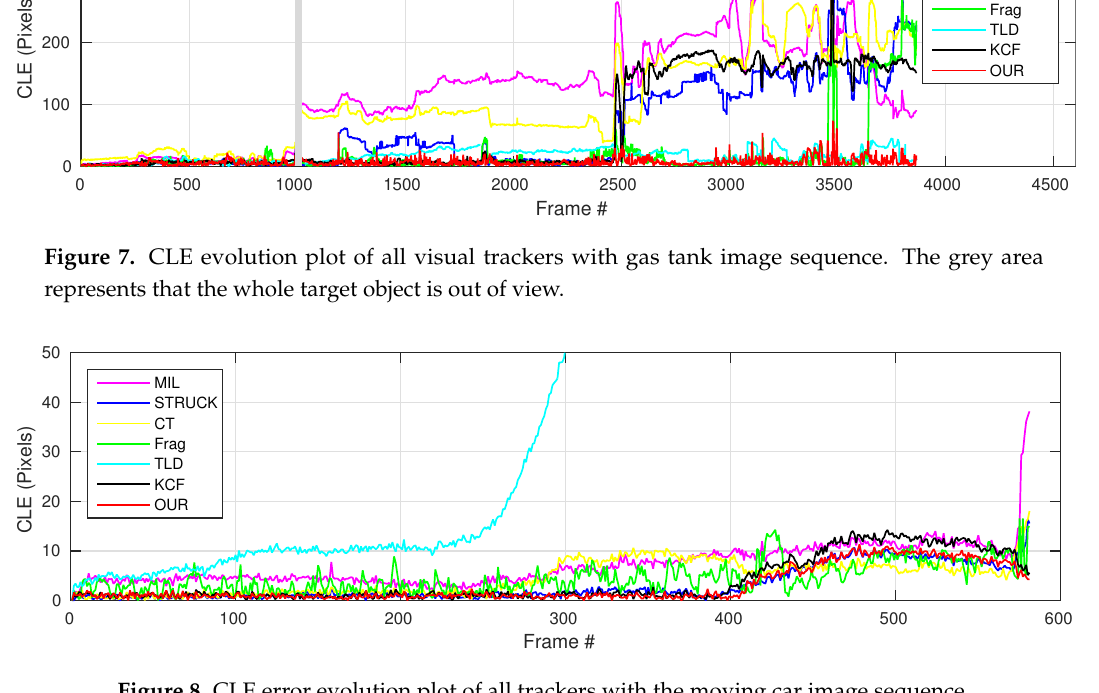
Figure 8. CLE error evolution plot of all trackers with the moving car image sequence.